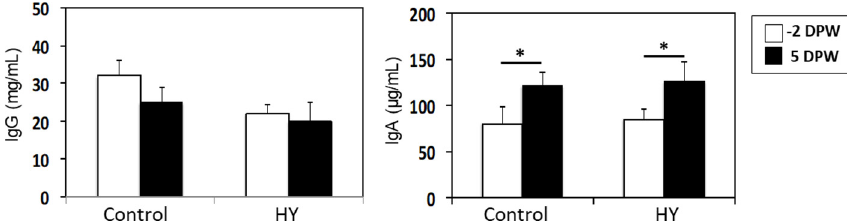
Figure 4. Changes in the serum IgG and IgA levels in the control- and HY calf starter-fed calves after weaning. The levels of immunoglobulins in the blood were assessed via an ELISA assay. The asterisks indicate significant differences between -2 and 5 DPW ( p < 0.05). Data are presented as the mean ± SE. DPW, days post-weaning.